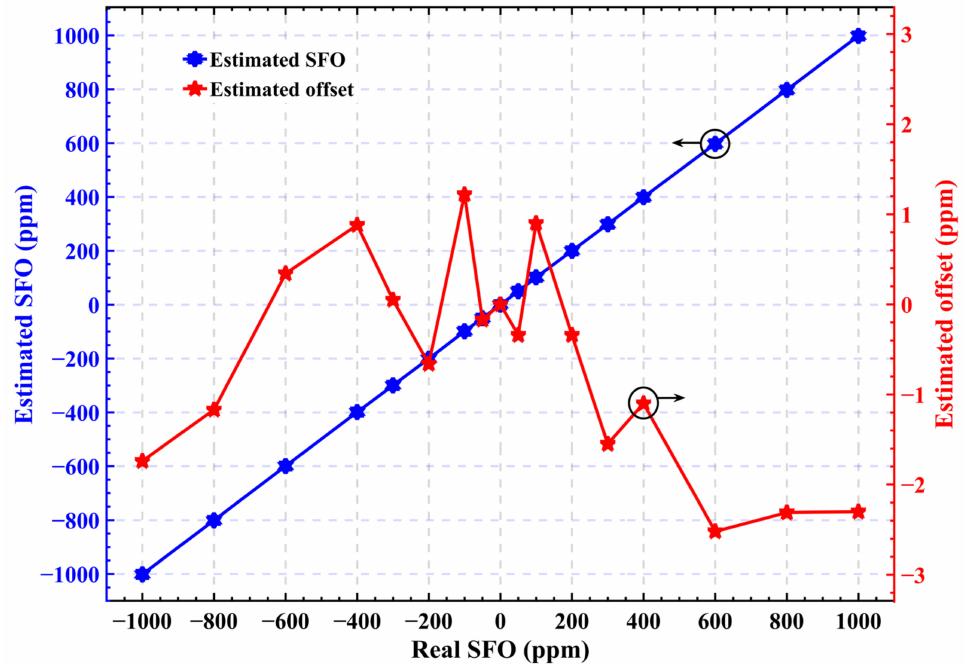
Figure 5. Estimated SFO value and estimation offset versus real